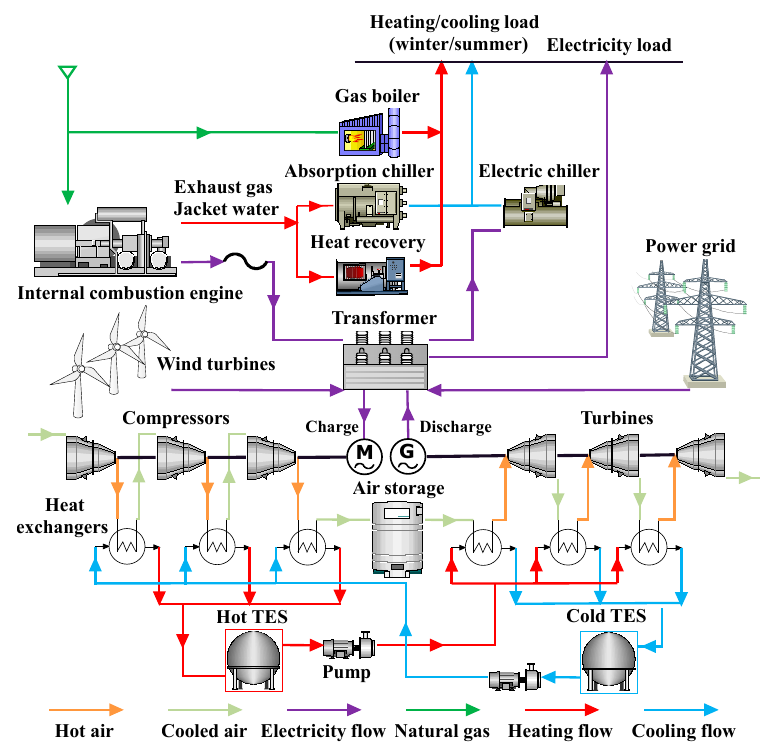
Figure 1. The structure of the HES with CAES.